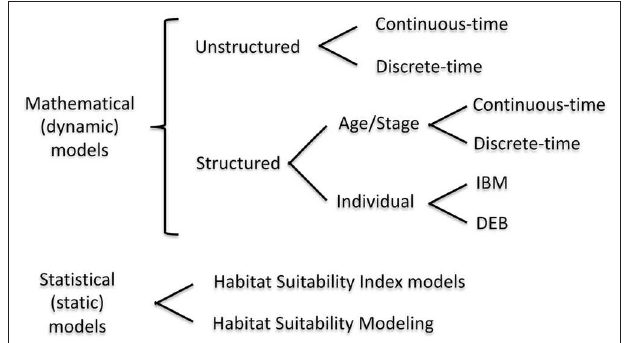
FIGURE 1 | Mathematical modeling approaches that can include habitat variability. IBM, Individual Based Model; DEB, Dynamic Energy Budget model. We do not consider community food web or ecosystem models, such as EcoSpace, in this